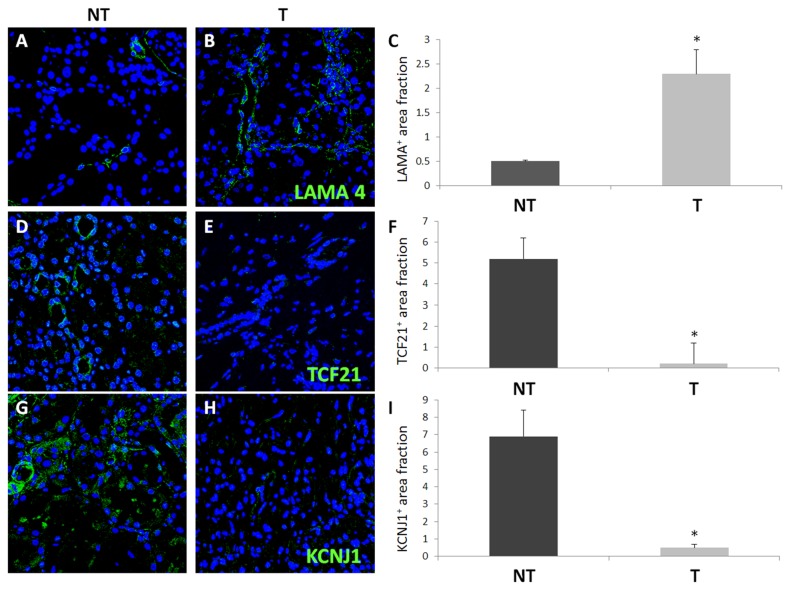

In
situ analysis for LAMA4+, TCF21+ and KCNJ1+ using confocal laser scanning microscopy.RCC tumor tissues (T) were characterized by a significant increase of LAMA4 expression (B) and decrease of TCF21 (E) and KCNJ1 (H) expression as compared to non-tumoral (NT) kidney portion (A, D, G). Nuclei are highlighted with TO-PRO in blue, Quantification of specific protein expression was obtained as described in the Methods section, (C, F, I). Results are expressed as mean ± S.D. For each group, all images (magnification 63X) are from a single patient and are representative of the whole group of patients.